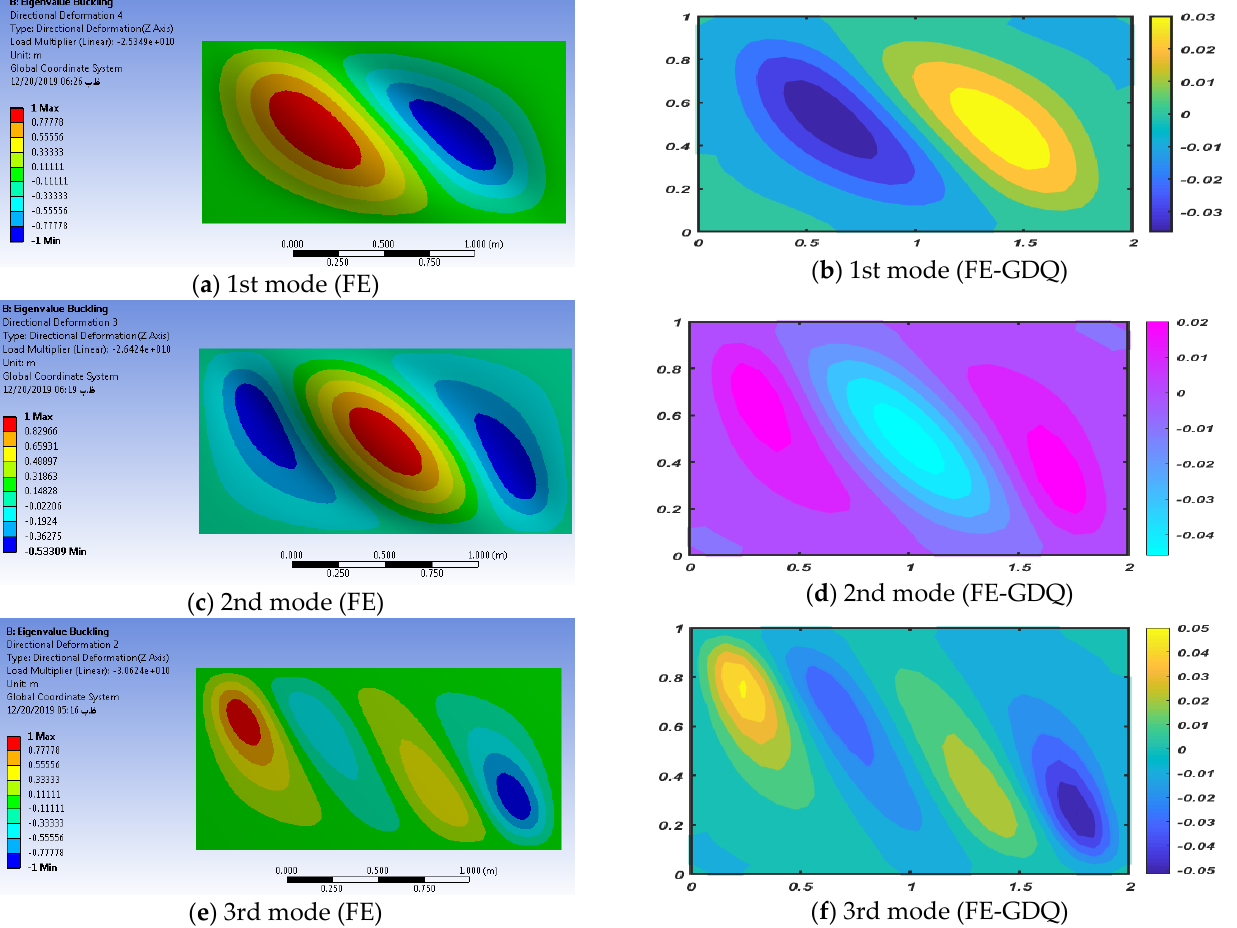
Figure 2. Comparative evaluation of the first three buckling mode shapes for a SSSS homogenous plate under a shear loading condition. Table 2. First four shear buckling loads for a SSSS FG-saturated porous plate with different aspect ratios, a / b , porosity distributions and porosity coefficients, e 0 , keeping β = 0.6